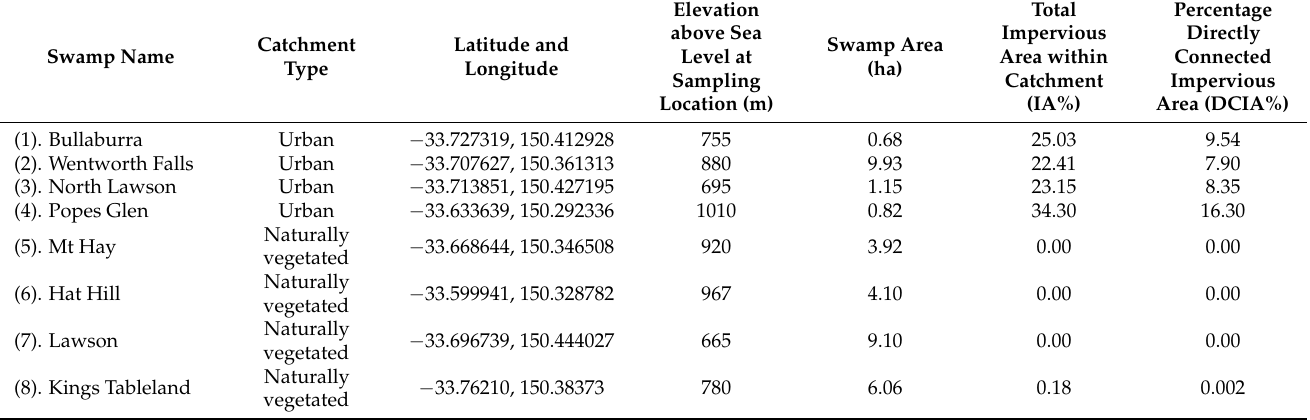
Table 1. The location and details of the eight Temperate Highland Peat Swamps on Sandstone (THPSS) study sites from which water and sediment were